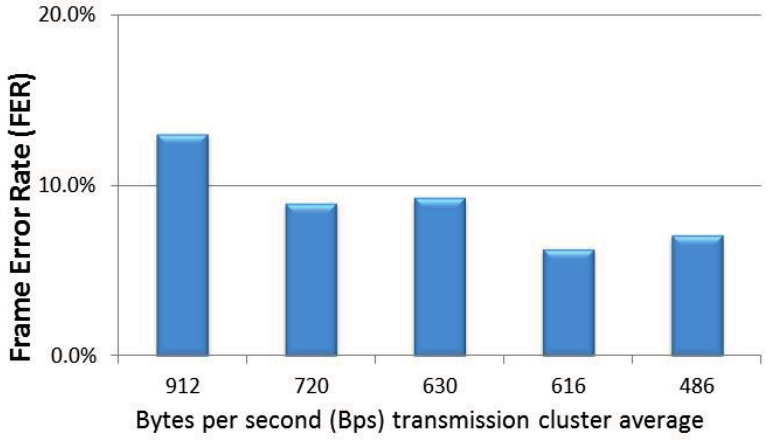
Figure 9. Frame Error Rate (FER) in the experimental scenarios.